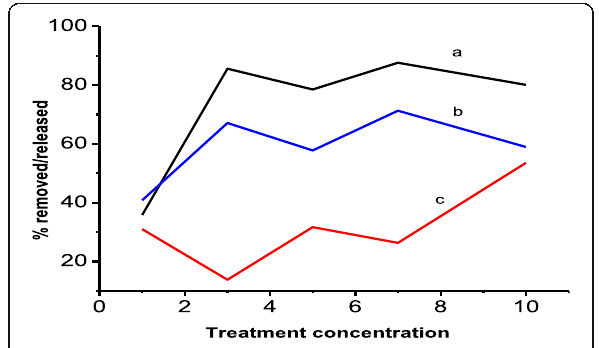
Fig. 1 Effect of different concentration of NaOH. a Percentage of cellulose increased, b percentage of lignin removed, and c percentage of hemicellulose removed after 1, 3, 5, 7, and 10% NaOH